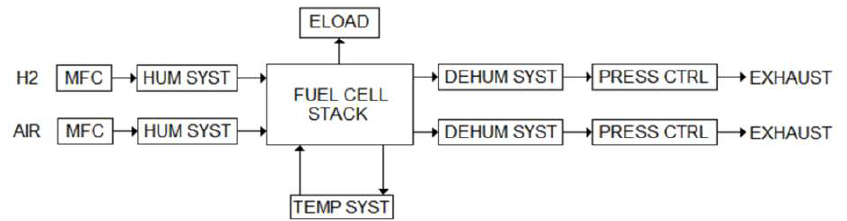
Figure 1. Fuel cell test bench subsystems.